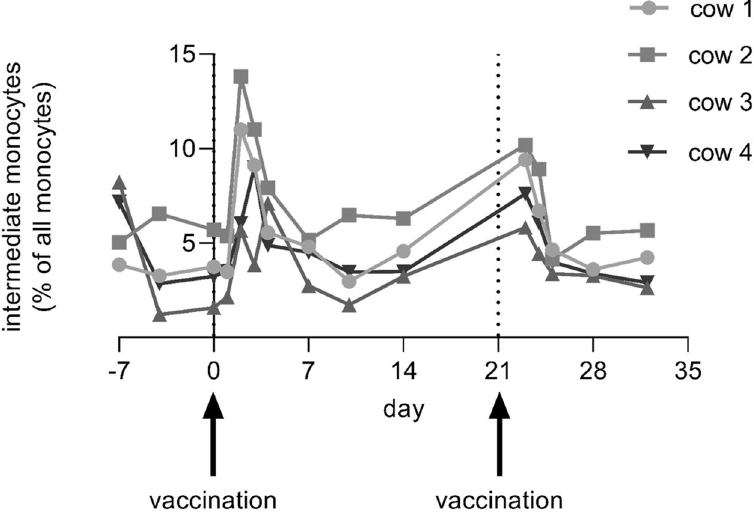
Figure 4. Intermediate monocytes concentration over time in four cows of group A using Bovalto Respi 3